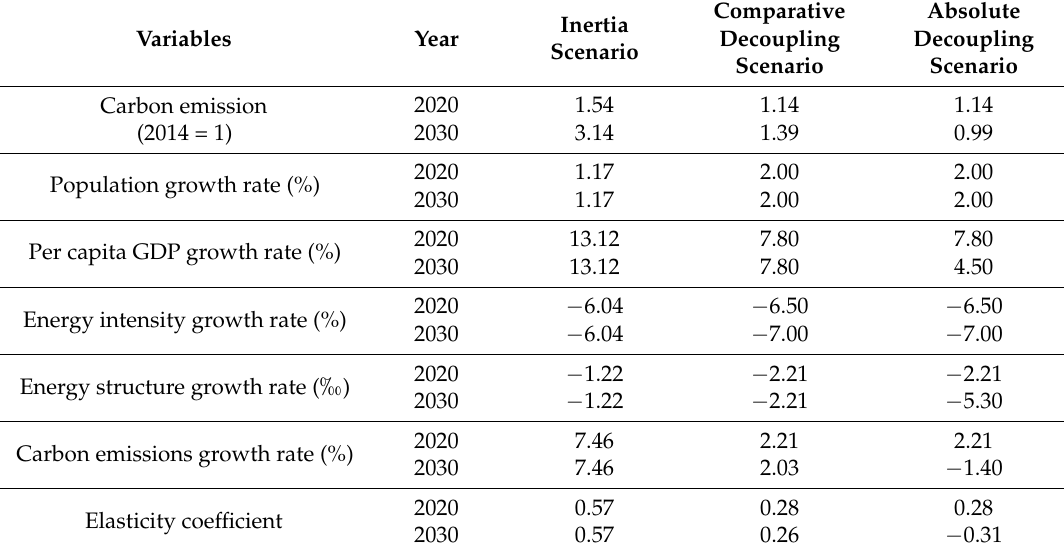
Table 2. Scenario analysis of carbon emissions in 2020 and